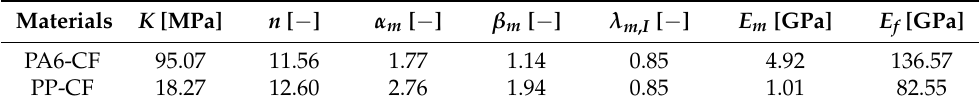
Table 2. Model constants for the Ramberg–Osgood flow stress model and a modified Hill’48 yield